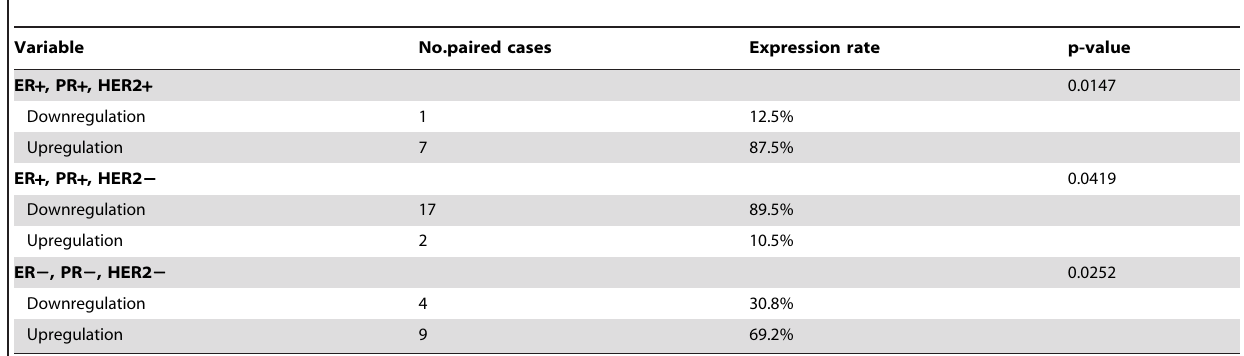
Table 2. Relationship between ER/PR/HER2 status and ZNF545 expression in paired breast cancer tissues.